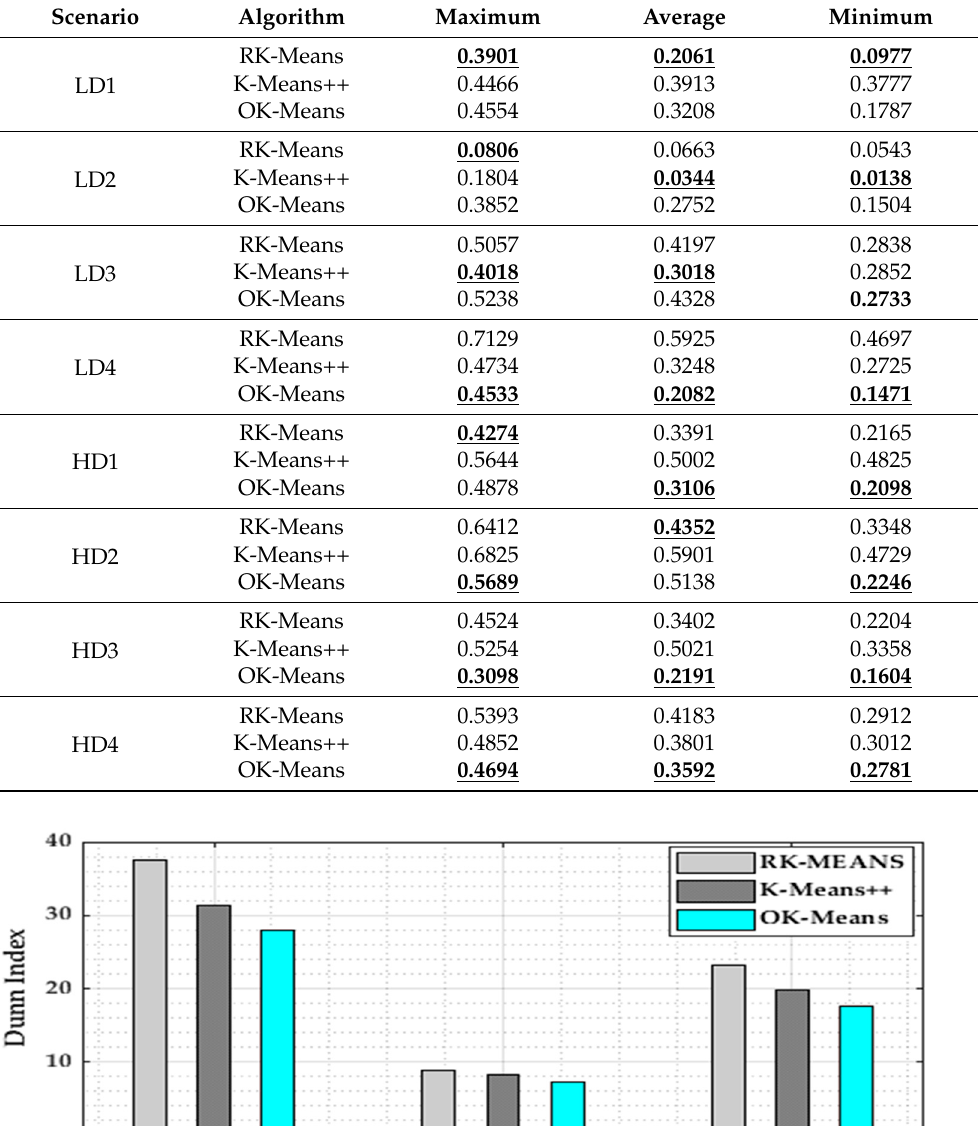
Table 9. DB numerical results.